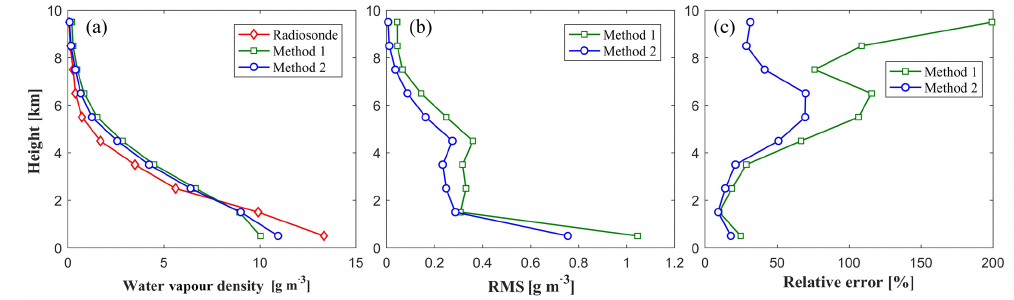
Figure 10. Water vapour profile comparison derived from different tomographic methods and radiosonde (a) , rms changes with altitude (b) and relative error changes with altitude (c) for the experimental period.